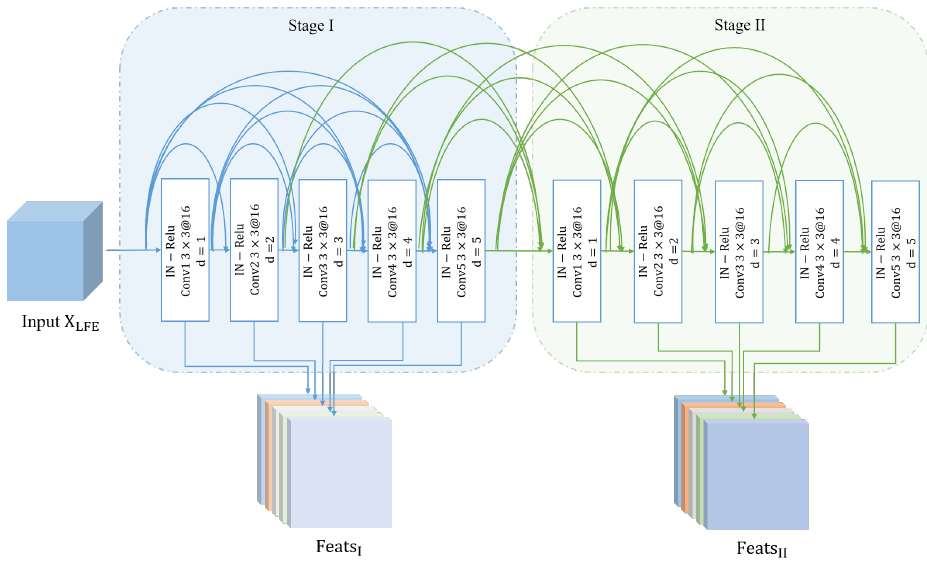
Figure 4. The structure of